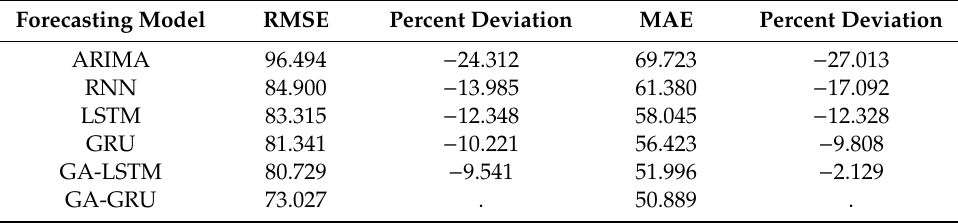
Table 3. The performance of di ff erent forecasting